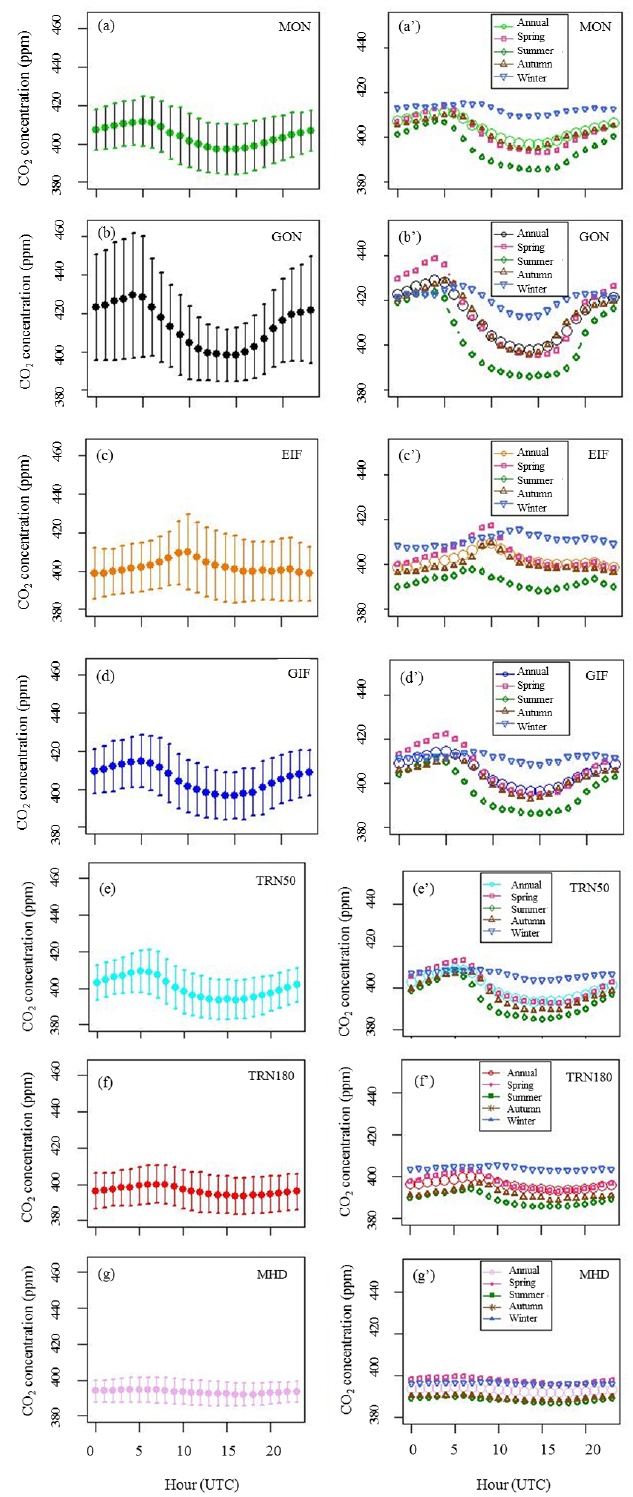
Figure 5. (a–d) Diurnal cycles of CO 2 from 1h averages at (a) MON (NE rural site, 9ma.g.l.), (b) GON (NE peri-urban site, 4ma.g.l.), (c) EIF (urban site, 317ma.g.l.) and (d) GIF (SW peri-urban site, 7ma.g.l.). (a’–d’) Diurnal cycles of CO 2 by season at (a’) MON, (b’) GON, (c’) EIF and (d’) GIF. Note that the left and right plot scales are not the same. (e–g) Diurnal cycles of CO 2 from 1h averages at (e) TRN50 (SW rural site, 50ma.g.l.), (f) TRN180 (SW rural site, 180ma.g.l.) and (g) MHD (remote site, 15ma.g.l.). (e’–g’) Diurnal cycles of CO 2 by season at (e’) TRN50, (f’) TRN180 and (g’) MHD. Note that the left and right plot scales are not the